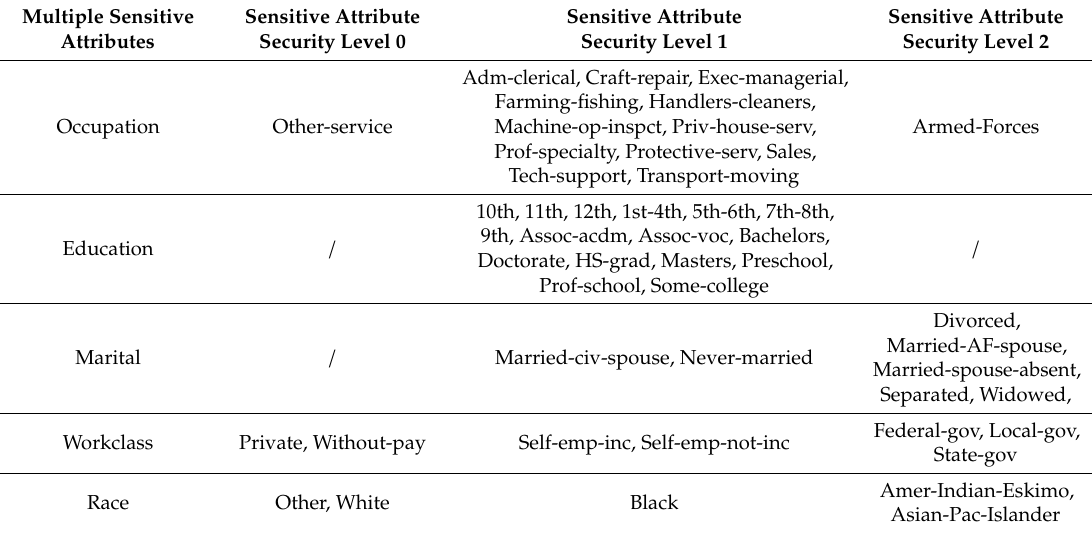
Table 3. Di ff erent sensitive attribute security levels for the multiple sensitive attributes of the microdata.